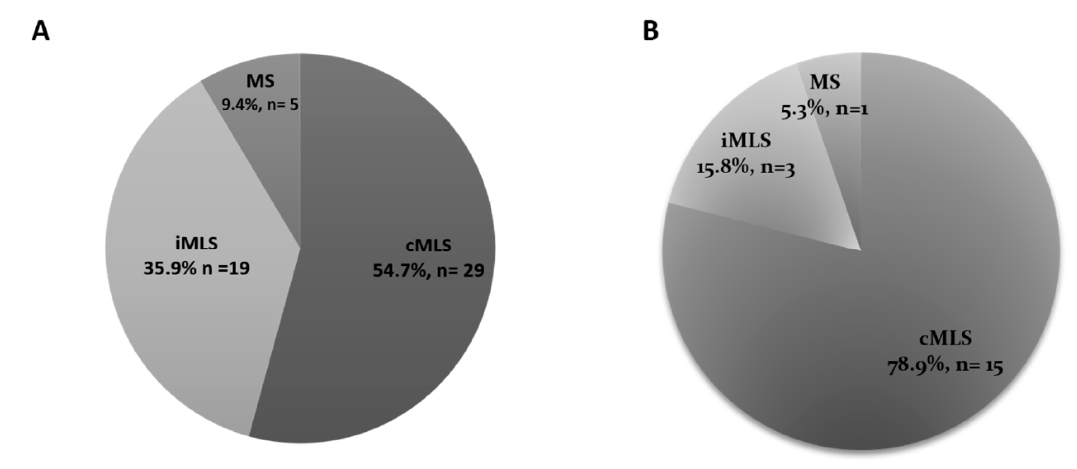
Figure 2. Distribution of MAC-resistance phenotypes among the resistant S. aureus isolates ( A ), and coagulase-negative Staphylococcus sp. isolates ( B ). The cMLS phenotype was the most frequent with 54.7% and 78.9% prevalence among S. aureus and CoNS isolates, respectively.